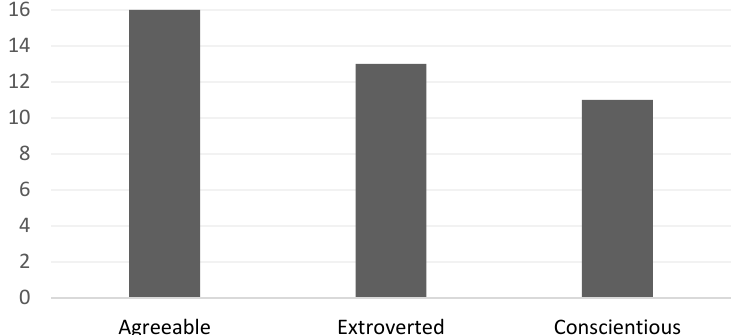
Figure A2. Students ’ preference for chatbots.